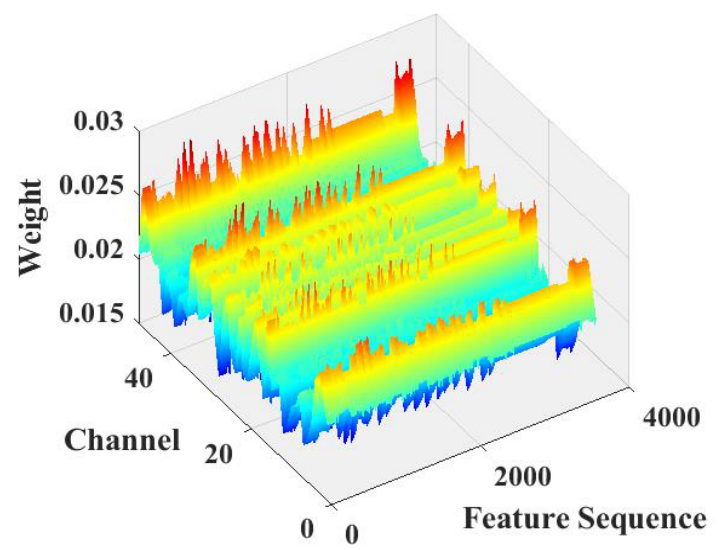
Figure 9. Weight of every channel of AdaSE (Normal).